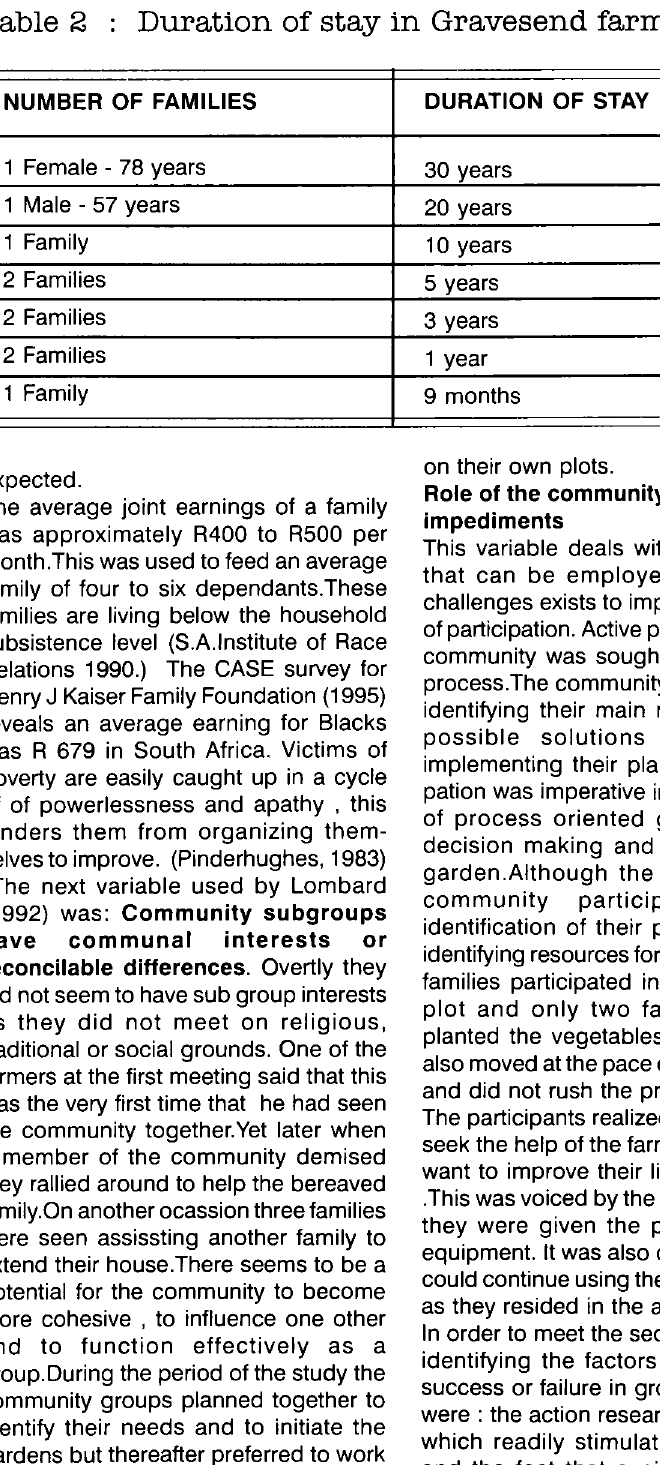
Figure 1 : Process orientated goals